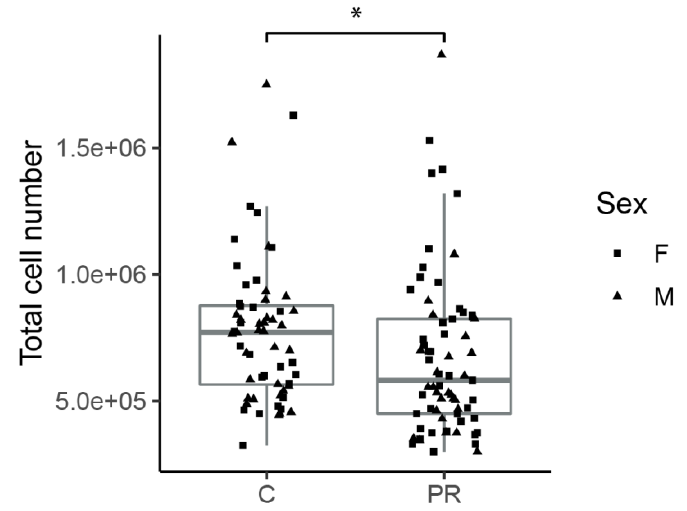
Figure 1. Total number of cells obtained from each E17 fetal hypothalamus after mechanical dissociation. The cells were counted on a hemocytometer (PR: n = 27 males and 42 females C: n = 32 males and 28 females). (two-way ANOVA: group effect * p = 0.04, sex effect p = 0.35) (boxplot: median, first and third quartiles).